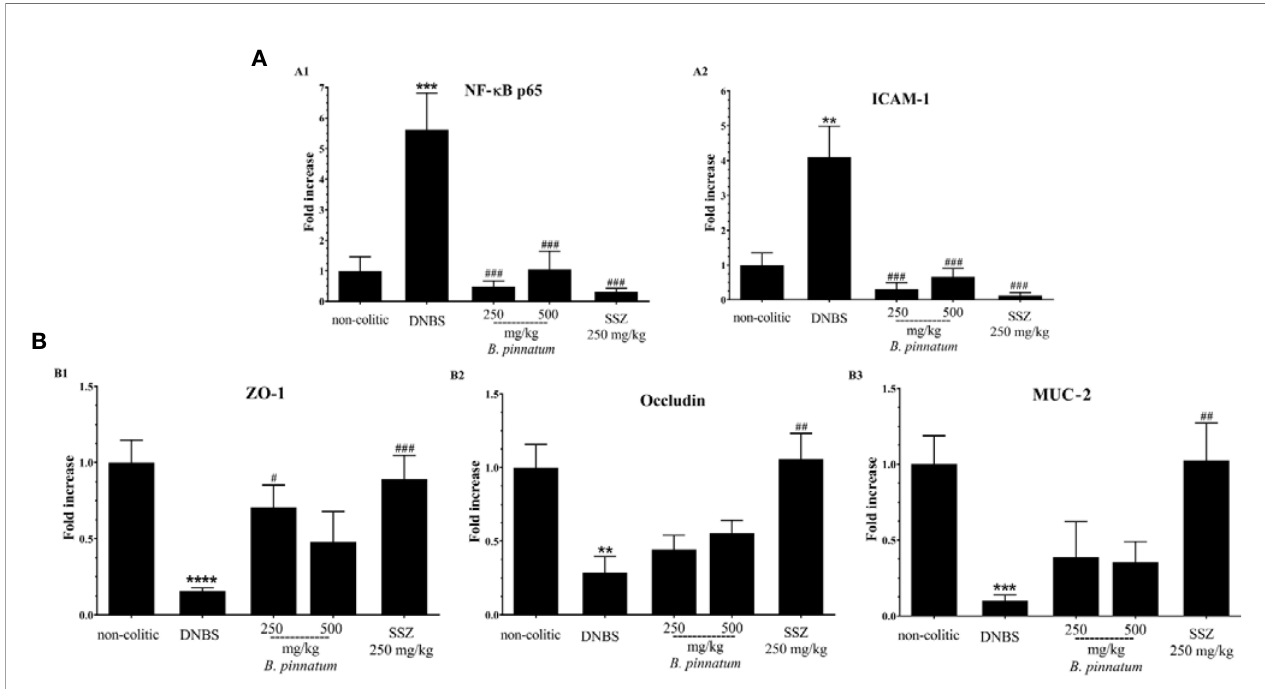
FIGURE 4 | Effect of hydroethanolic extract from B. pinnatum leaf (HEBP) on colonic gene expression of different mediators in 2.4-dinitrobenzene sulfonic acid (DNBS) – induced colitis analyzed by reverse transcription − quantitative polymerase chain reaction (RT-qPCR). In fl ammation markers (A) : NF- k B p65 (A1) , ICAM-1 (A2) , and markers involved in epithelial barrier integrity (B) : ZO-1 (B1) , occludin (B2) , and MUC-2 (B3) . Data (n = 8) are presented as mean ± standard error from the mean. ** p < 0.01, *** p < 0.001, **** p < 0.0001 compared with non-colitic group; # p < 0.05, ## p < 0.01, ### p < 0.001, compared with DNBS